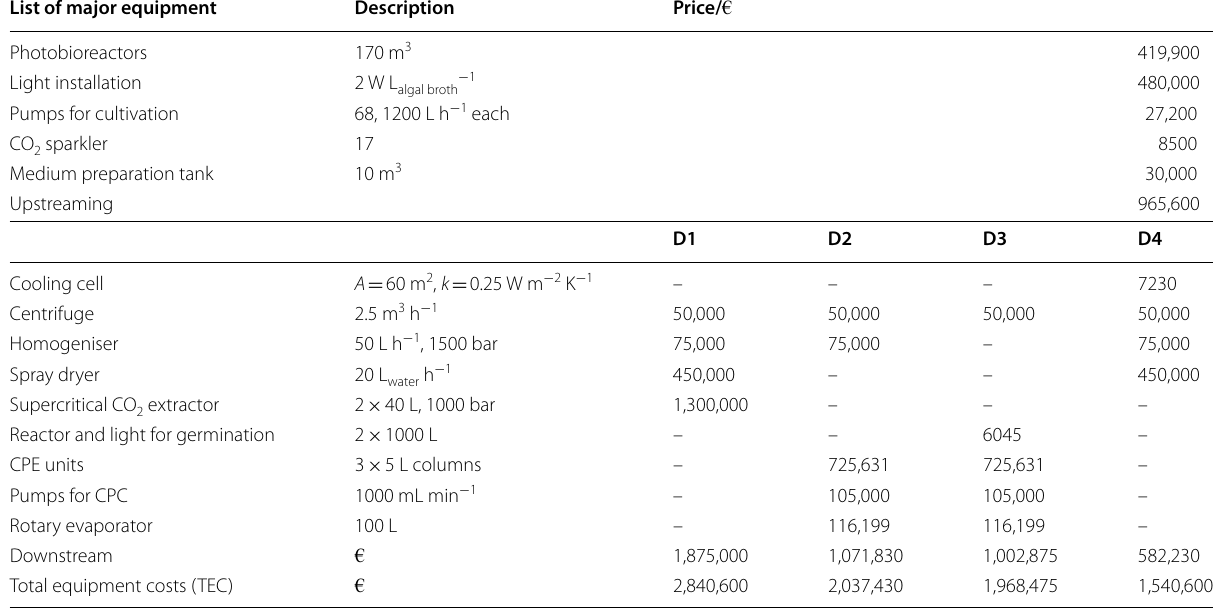
Table 4 Major equipment and total equipment costs (TEC) for the upstream and the four downstream scenarios D1, D2, D3, and